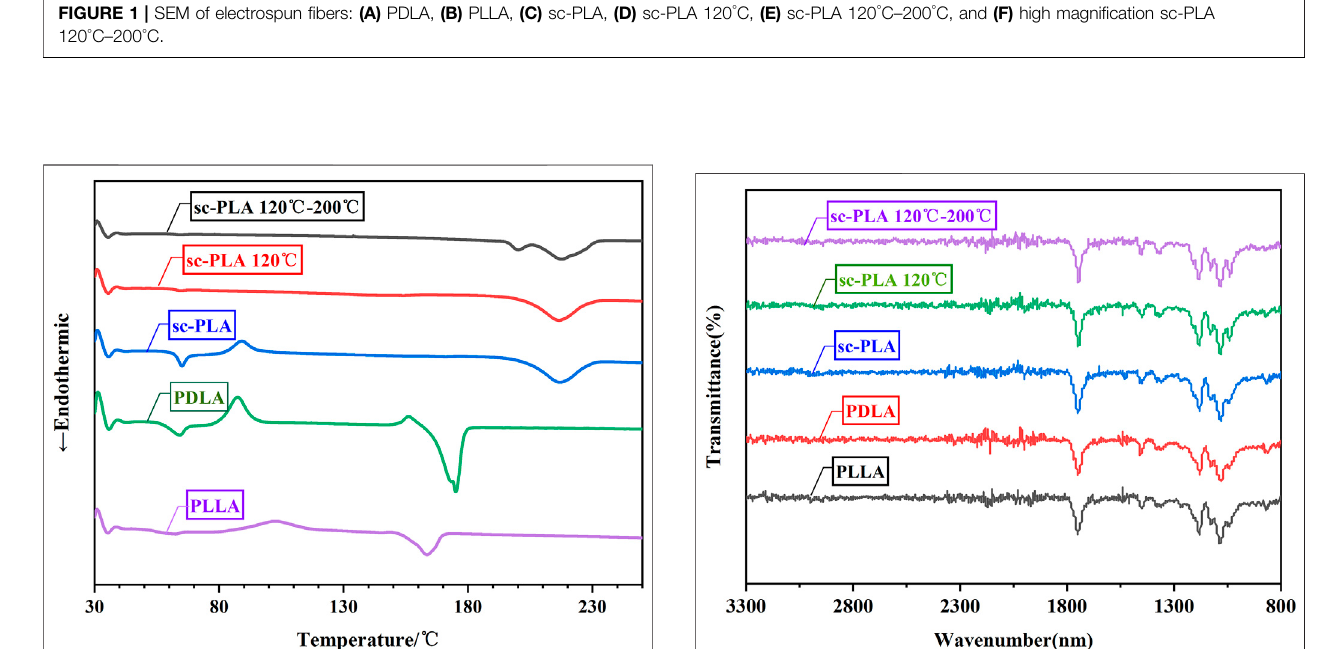
FIGURE 3 | FTIR spectra of electrospun fi bers of PLLA, PDLA, sc-PLA, sc-PLA 120 ° C, and sc-PLA 120 – 200 ° C.